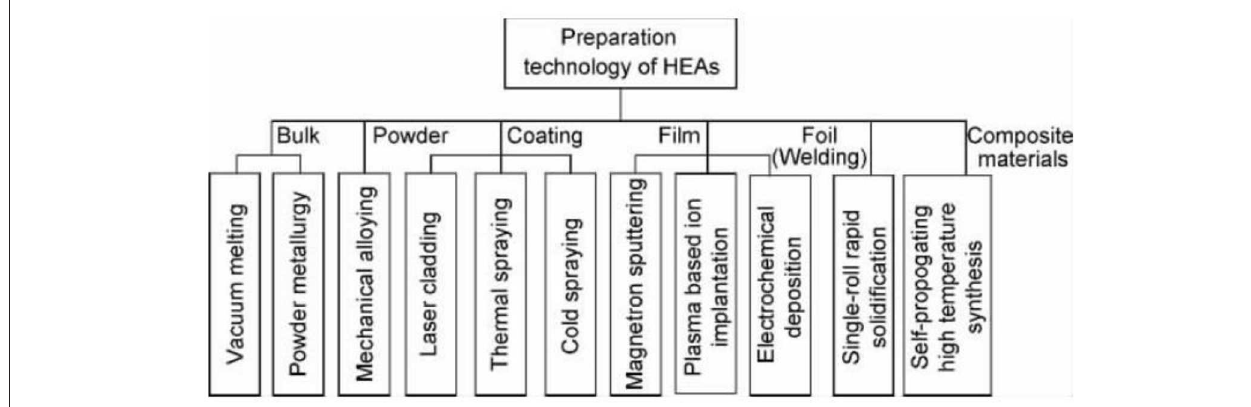
FIGURE 1 | Research and preparation methods of different forms of samples.